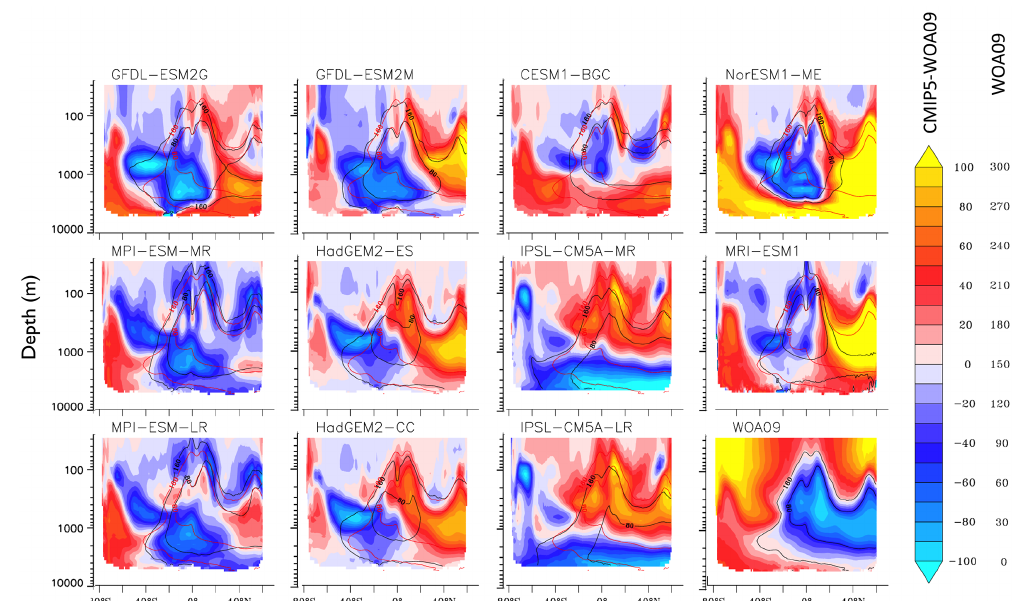
Figure 2. Differences between CMIP5 models’ estimates and WOA09 climatological observations of oxygen concentration (mmolm − 3 ) zonally averaged from 160 to 60 ◦ W in the Pacific at various depths and latitudes during the historical period (1960–1999). The last panel shows the corresponding zonal mean oxygen concentrations (mmolm − 3 ) from the observational WOA09 data set. In each panel, oxygen concentrations equal to 80 and 160mmolm − 3 , respectively, are represented by superimposed contour lines (black for each model and red for observations).